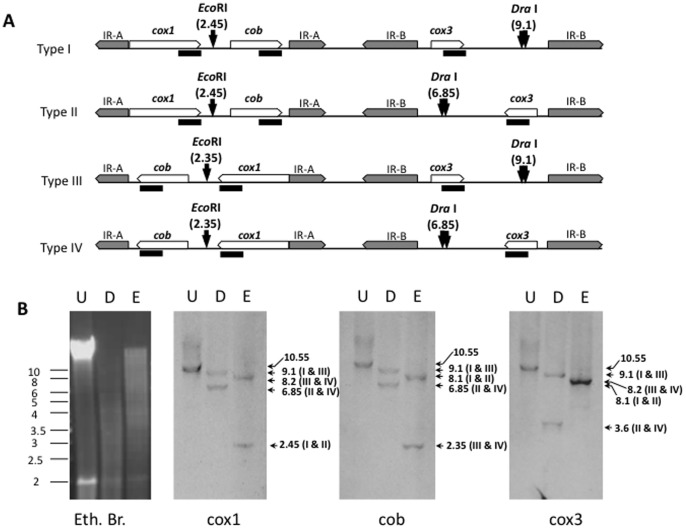
Evidence for a linear configuration and 4 structural types of the mitochondrial genome in B. microti by Southern analysis.
A. Schematic representation of the linear configuration and the 4 structural types of the mitochondrial genome of B. microti. The protein encoding genes were used as genetic markers and target with specific probes (dark lines). Gene names are as described in Figure 6. IR-A and IR-B represent the two independent inverted repeats. DraI and EcoRI sites used to digest the genomic DNA and their positions on the molecules are represented. B. Southern blot analysis preformed with cox1, cob or cox3 probes (black bars) on of the R1 strain's mitochondrial DNA either undigested (U) or digested with DraI (D) or EcoRI (E). The theoretical sizes and associated types of mtDNA molecules are represented. Eth. Br.: Ethium bromide-stained agarose gel.